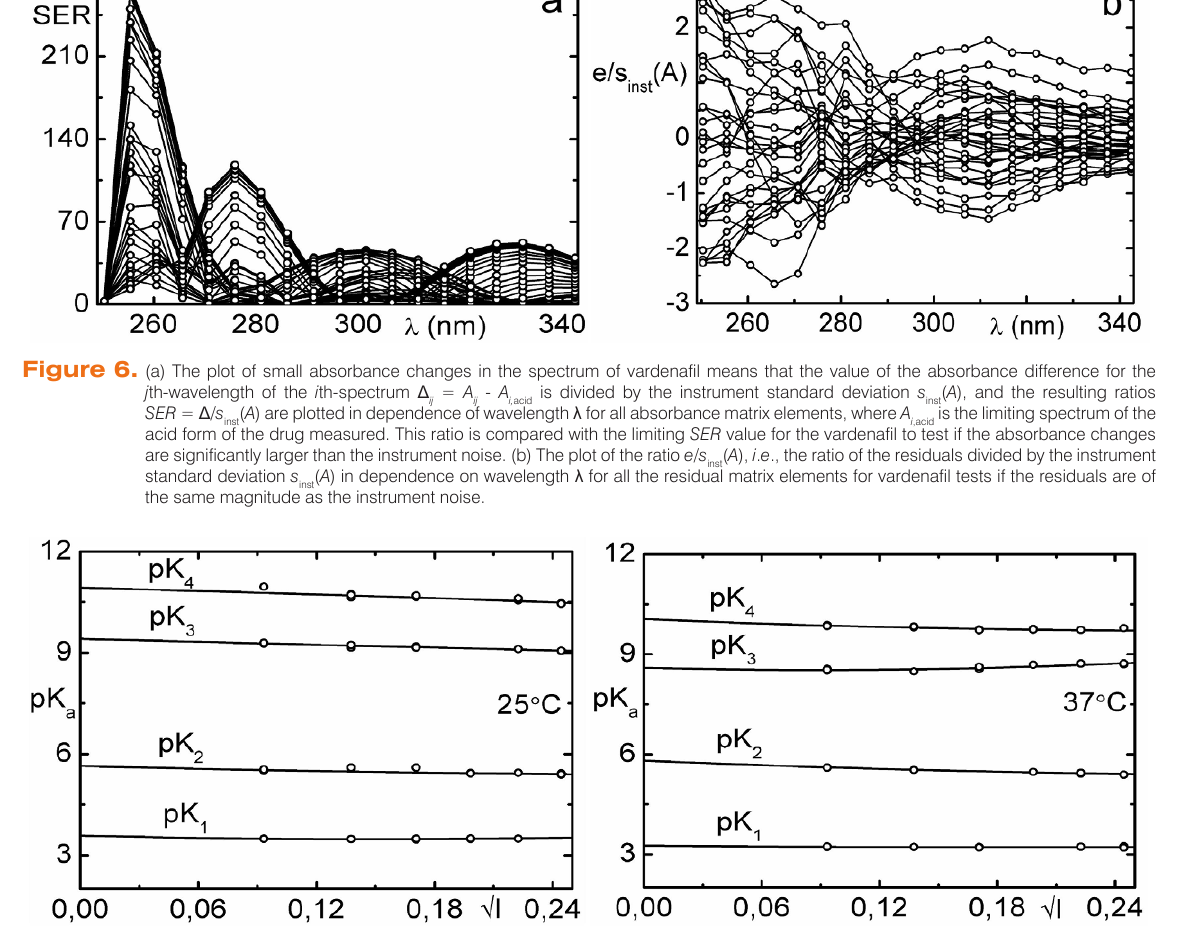
of vardenafil on the square root of an ionic strength at 25°C and a